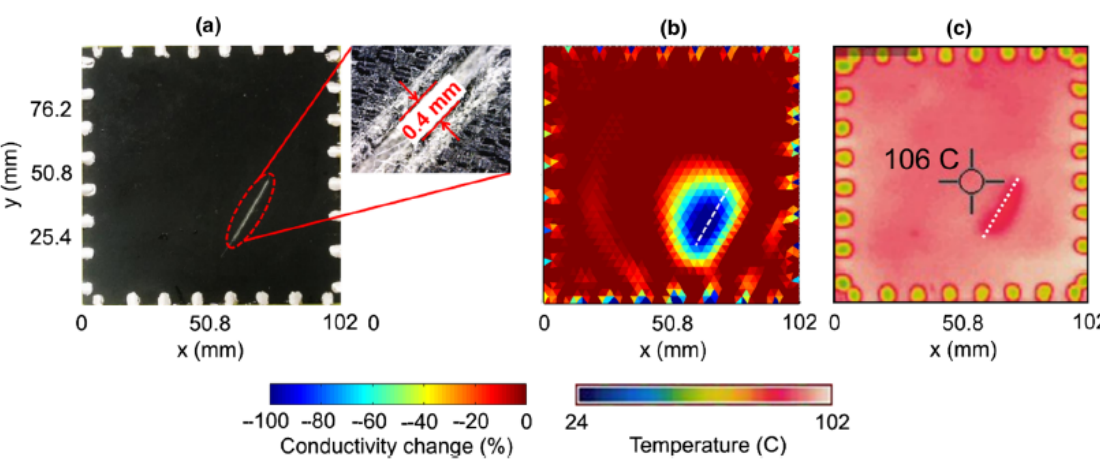
Figure 8. ( a ) CNT composite sensor on the specimen with artificial crack; ( b ) EIT maps of normalized conductivity change and ( c ) map from IR thermography [156].